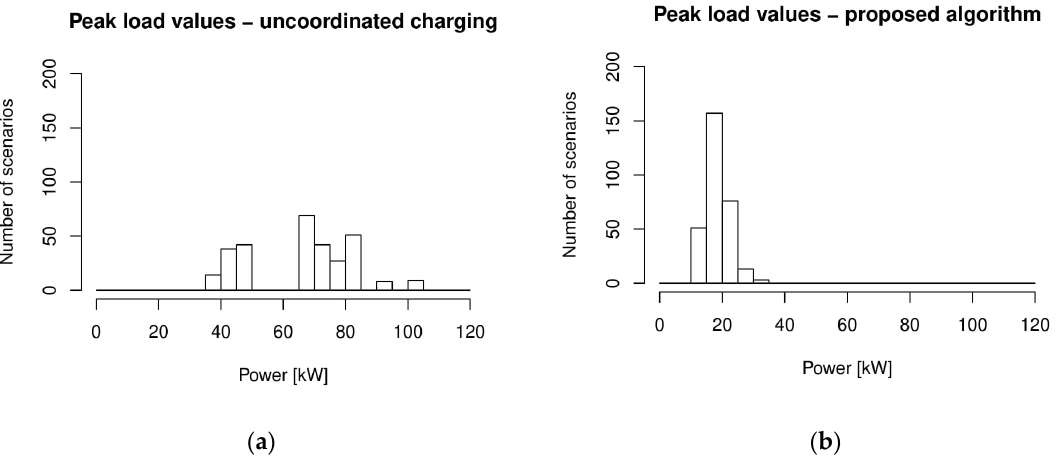
Figure 7. A summary of peak load values in simulated scenarios. ( a ) Peak power values when using uncoordinated charging. ( b ) Peak power values when using coordinated charging.